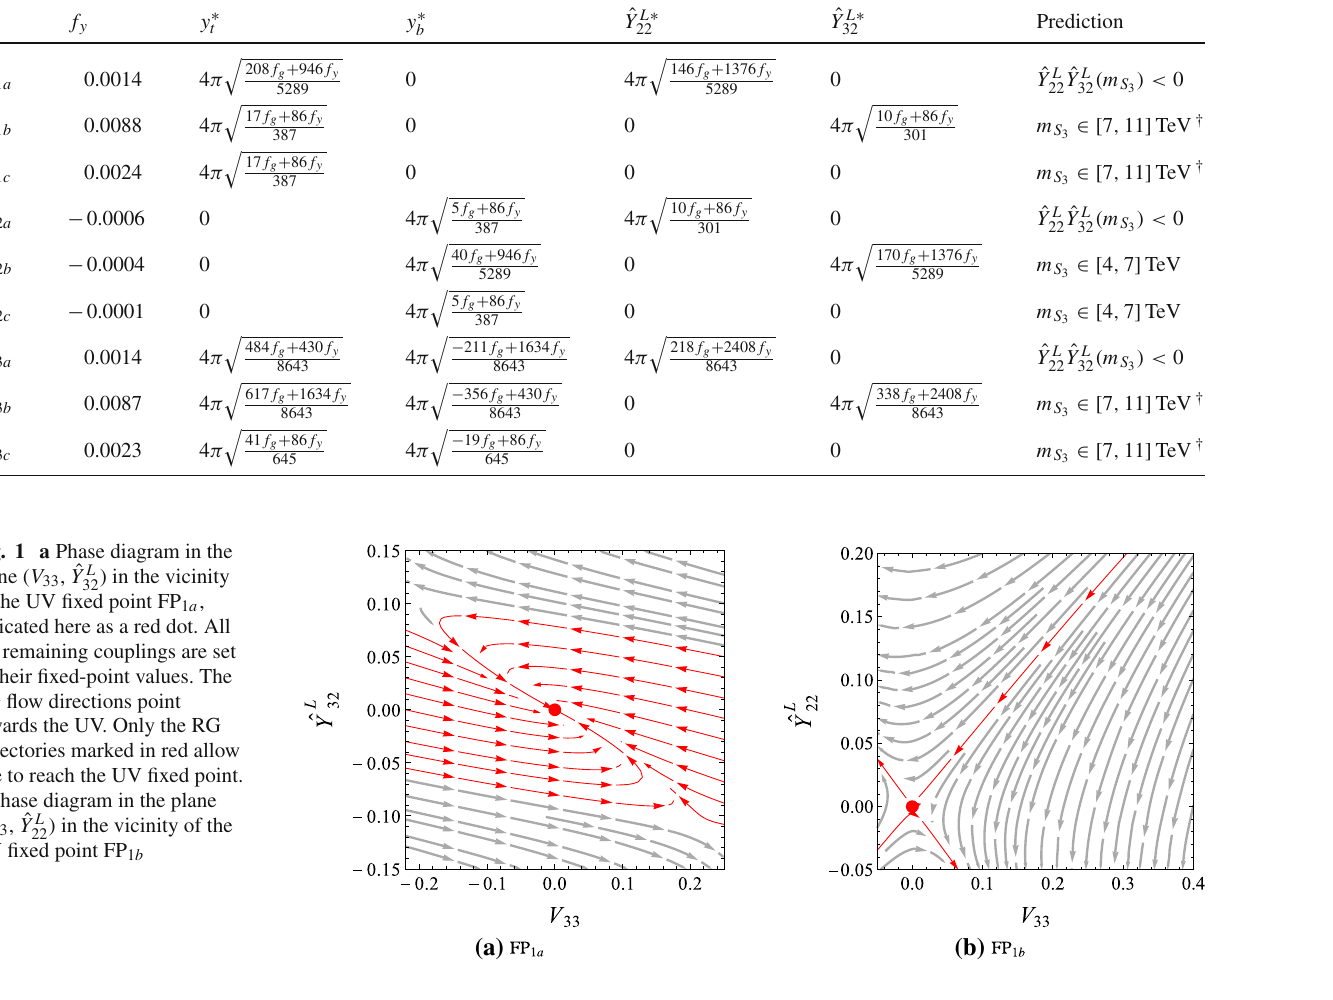
Table 1 Fixed-point values and the corresponding f y of the SM+ S 3 Yukawa coupling system invoked for an explanation of the b → s anomalies. The low-energy prediction for the NP sector is shown in the last column on the right. The symbol † indicates those scenarios in which the predicted top mass exceeds the experimental value